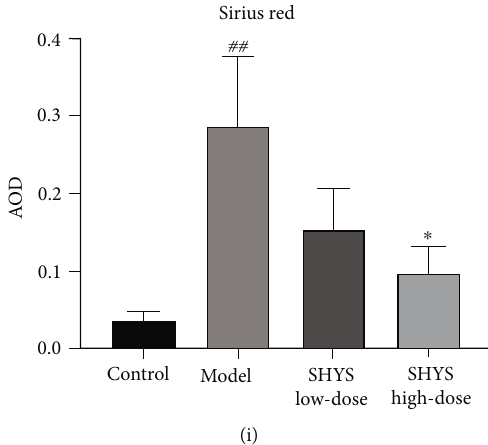
Figure 1: Therapeutic e ff ects of SHYS on DKD model rats. DKD rats were orally treated with di ff erent dosages of SHYS, the therapeutic e ff ects of SHYS on DKD were evaluated through measuring the body weight change, FBG, level of 24 h urine protein, and pathological changes in the kidney. (a) SHYS treatment reduced the body weight loss in DKD model rats. (b) SHYS treatment decreased the FBG level in DKD model rats. (c) SHYS treatment reduced the level of 24h urine protein in DKD model rats. (d, e) HE staining showed that the pathological changes in the kidney in DKD model rats were improved after SHYS treatment (black arrows indicated the glomerular hyperplasia; blue arrows indicated the renal tubule atrophy; yellow arrows indicated the in fl ammatory cell in fi ltration) ( 200 × ) (d). SHYS treatment also lowered the HE score of kidney injury in rats with DKD (e). (f) – (i) The Masson (f, g) and Sirius red (h, i) staining showed that SHYS treatment decreased the accumulation of collagen contents in kidney (black arrows indicated the positive expression area) ( 200 × ). Control, model, SHYS low-dose, and SHYS high-dose groups ( n = 10 per group) ## : P < 0 : 01 compared with the control group; ∗ : P < 0 : 05 compared with the model group; ∗∗ : P < 0 : 01 compared with the model group. Table 1: Levels of Cr and BUN in serum after SHYS treatment. Group